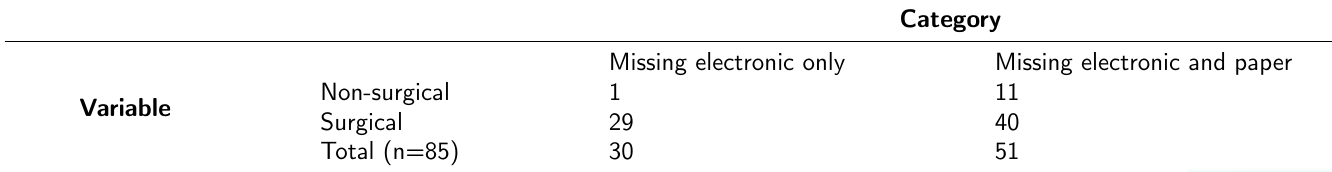
Table 4: Variables associated with missing electronic or paper discharge summaries from the extended chart review